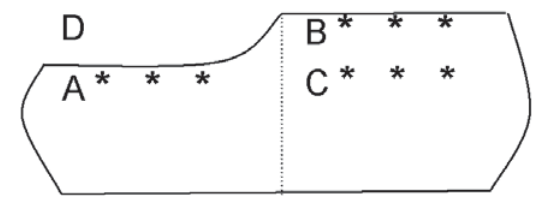
Figure 3- Points and regions of microhardness assessment in dentin. A- remaining sound dentin; B- (cid:17)(cid:11)(cid:18)(cid:7)(cid:19)(cid:20)(cid:21)(cid:5)(cid:22)(cid:23)(cid:9) (cid:4)(cid:7)(cid:22)(cid:23)(cid:6)(cid:4)(cid:24)(cid:9) (cid:16)(cid:7)(cid:25)(cid:6)(cid:5)(cid:25)(cid:26)(cid:9) (cid:27)(cid:28)(cid:9) (cid:16)(cid:7)(cid:7)(cid:18)(cid:9) (cid:4)(cid:7)(cid:22)(cid:23)(cid:6)(cid:4)(cid:24)(cid:9) (cid:16)(cid:7)(cid:25)(cid:6)(cid:5)(cid:25)(cid:26)(cid:9)